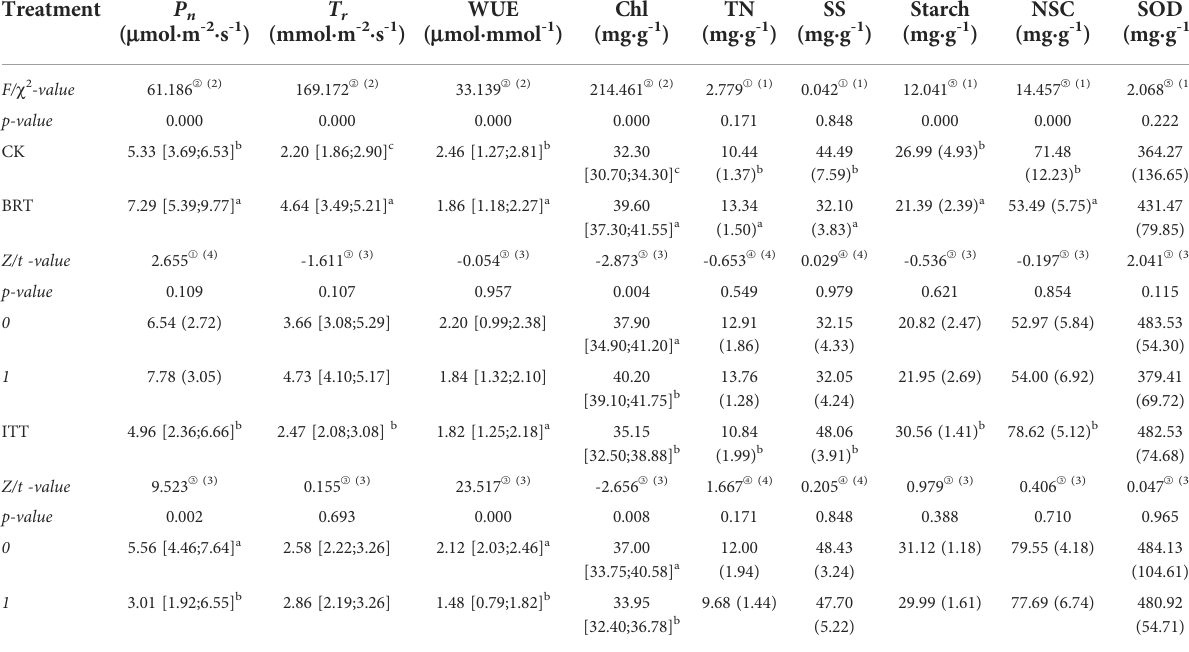
TABLE 4 Physiological variables among the treatments and their orientation traits.